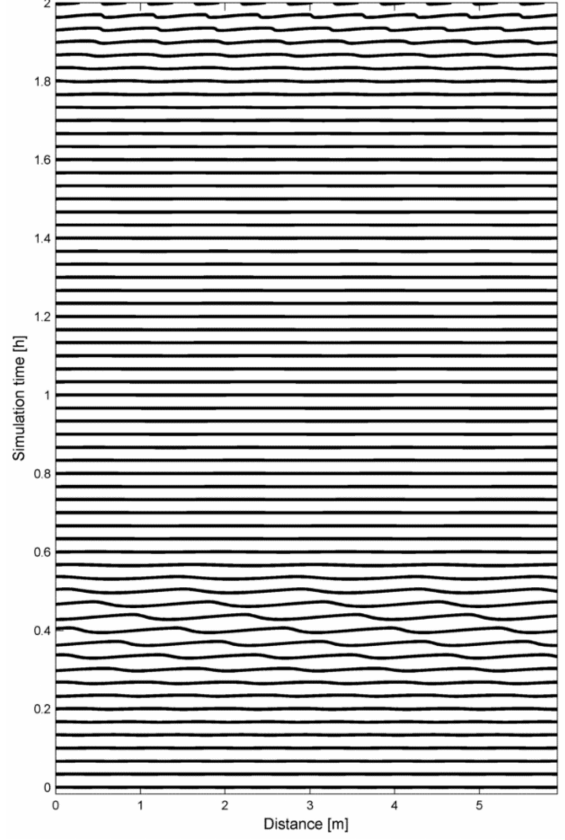
Figure 6. Dune field over time, using scenario A4 from Shimizu et al. (2009).